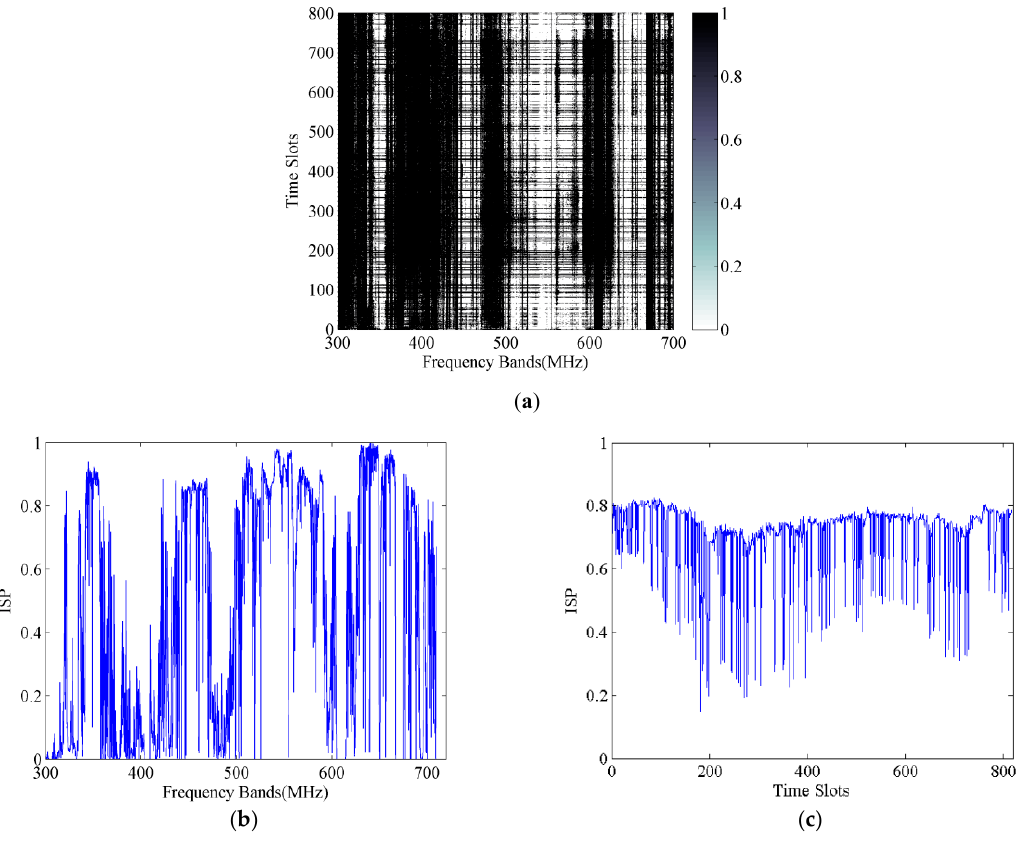
Figure 7. Twenty-four-hour PSD data preprocessing in 300 MHz–700 MHz band. ( a ) Sub-bands occupancy; ( b ) ISP in the frequency domain; ( c ) ISP in the time domain. occupancy; ( b ) ISP in the frequency domain; ( c ) ISP in the time